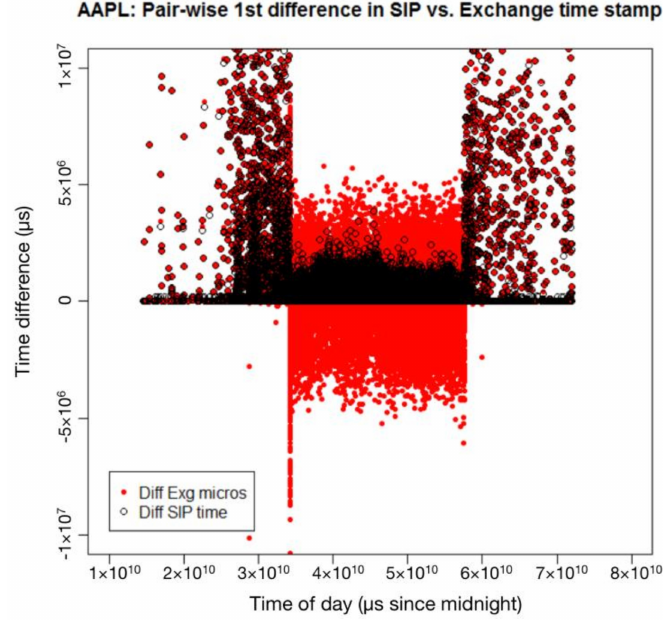
Figure 20. Time difference in SIP vs. exchange time stamp for AAPL stock on 11 August